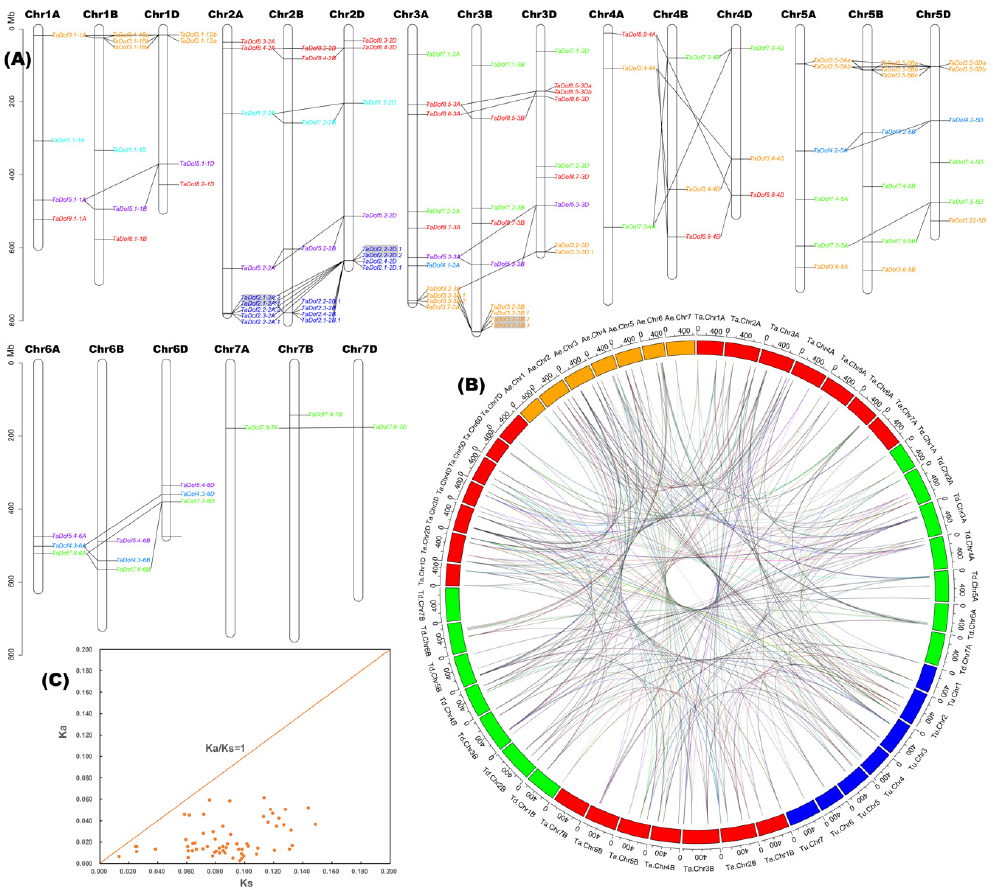
Figure 4. Syntenic analysis of TaDofs. ( A ) Chromosomal locations of 108 Dof genes in wheat. Gene classes are in different colors. Cyan, Group I; dark blue, Group II; orange, Group III; blue, Group IV; purple, Group V; green, Group VII; dark red, Group VIII. Segmentally duplicated homologous genes and tandemly duplicated genes are indicated with gray lines and gray rectangles, respectively. ( B ) Genome-wide syntenic analysis among common wheat (Ta, AABBDD, red box) and progenitor species Aegilops tauschii (Ae, DD, orange box), T . urartu (Tu, AA, blue box), and T . dicoccoides (Td, AABB, green box). ( C ) Ka/Ks values for duplicated TaDof gene pairs.